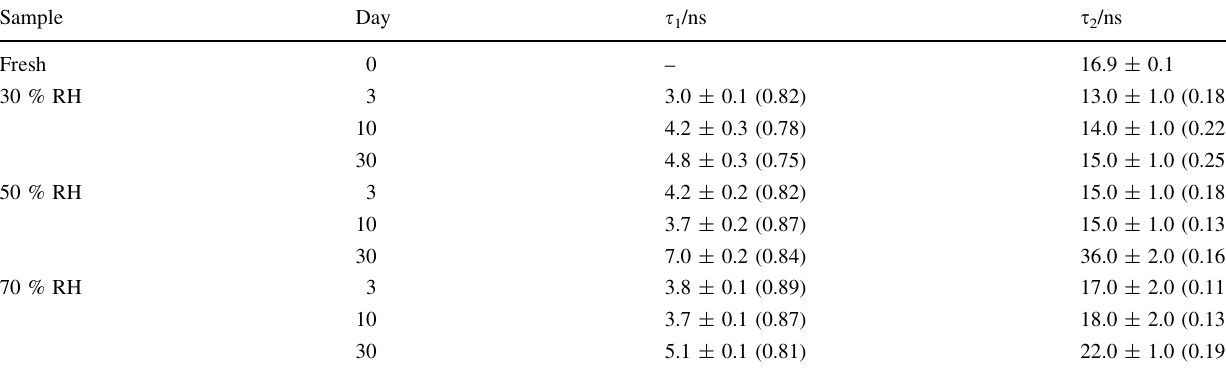
Table 1 PL decay lifetimes of fresh and aged perovskite films